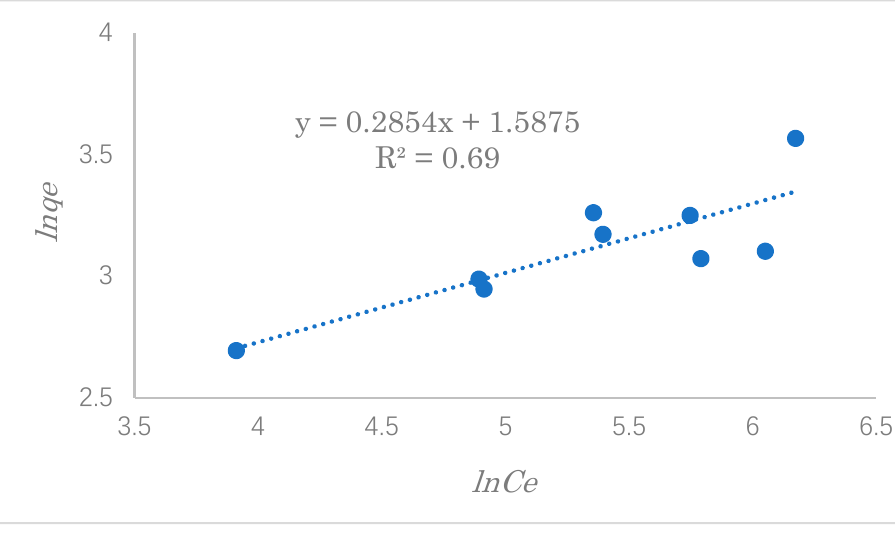
Figure 14. The Freundlich isotherm for the adsorption of SDS by modified cellulose. Table 3 shows the linear constants ( R 2 ) and other parameters of the two isotherm mod- Table 3. Isotherm parameters for SDS adsorption by modified cellulose. els for the modified cellulose adsorption of SDS calculated according to Figures 13 and 14. By comparing the two values of R 2 , we can see that the adsorption isotherms can generally be described more satisfactorily by the Langmuir isotherm. In addition, the value of R L is between 0 and 1 when the initial concentration is 100 mg · L − 1 . This result suggests that the adsorption of SDS on the modified cellulose mainly occurred by a monolayer reaction with the strong adsorption force. The maximum adsorption capacity was estimated to be 22.8 mg · g − 1